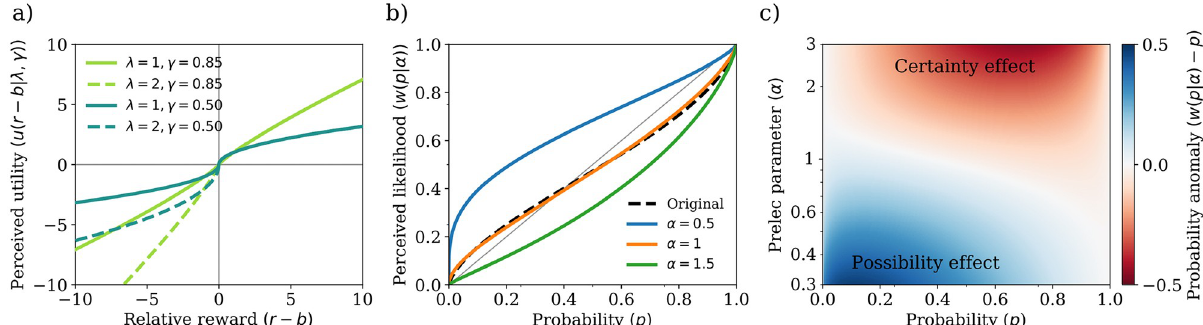
Fig 1. Utility and probability weighting functions used in cumulative prospect theory. (a) Utility functions for gains ( u ( r − b | γ ) = ( r − b ) γ , for r > b ) and losses ( u ( r − b | λ , γ ) = − λ | r − b | γ , for r < b ) used in the calculation of value under cumulative prospect theory. These are convex for gains and concave for losses, to mimic a diminishing marginal returns effect on relative rewards. Steeper utility function for losses shows loss aversion, by amplifying the perception of a loss when compared to a gain of similar magnitude. (b) Prelec’s probability weighting function, w ( p | α , δ ) = exp{ − α ( − log ( p )) δ }, is plotted for different values of the Prelec parameter α and for fixed δ = 0.75. The probability weighting function presented originally, w ð p j g Þ ¼ p g = ð p g þ ð 1 (cid:0) p Þ g Þ 1 g , is represented by the black dashed line, for γ = 0.85. Notice that Prelec’s function is very similar to the originally proposed probability weighting function when α = 1, demonstrating both overweighting of low probabilities and underweighting of high probabilities, corresponding to the possibility and certainty effects. (c) Probability anomaly, w ( p | α ) − p . Blue indicates positive anomaly, whereas red indicates negative anomaly. Here it is easy to see the effects of the probability weighting function; for low values of α , low probabilities are overweighted, causing the so-called possibility effect —i.e. highly unlikely events are perceived as more probable than they actually are ---, and, for high values of α , high probabilities are underweighted, demonstrating the certainty effect—i.e. highly likely events are perceived as less probable than they actually are. Notice that both the certainty and possibility effects come into play when α �